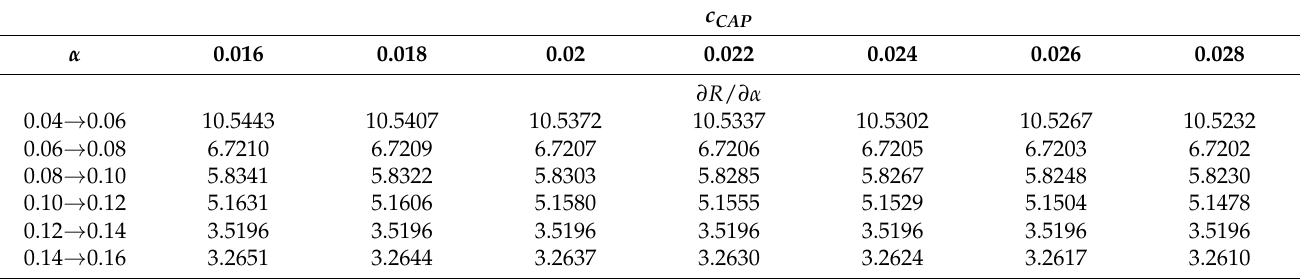
Table 10. Responsiveness of the guaranteed rate to the insurer’s leverage at various levels of c CAP . c